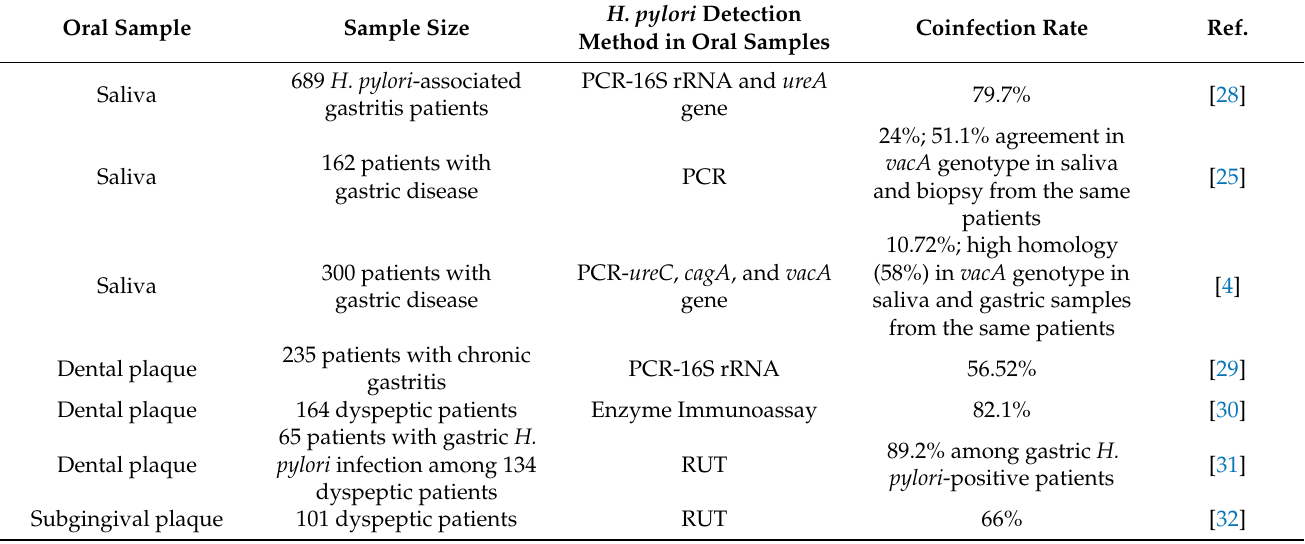
Table 1. Summary of data regarding H. pylori coinfection in gastric biopsy and oral